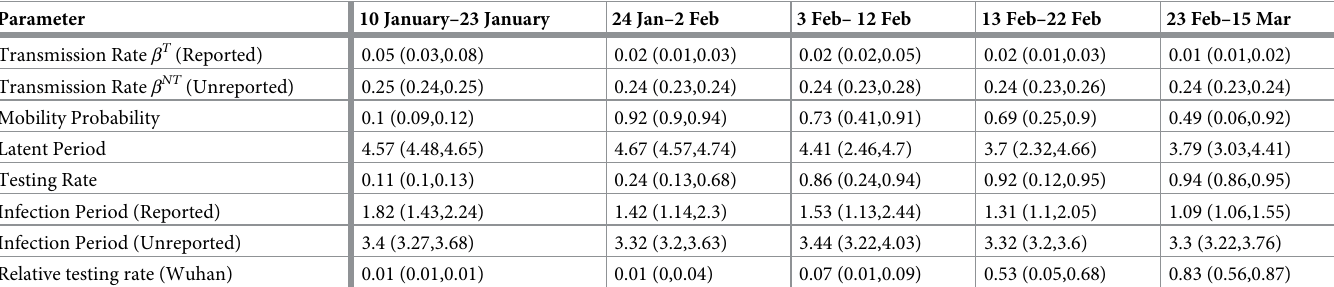
Table 1. Best-fit model estimates for key epidemiological